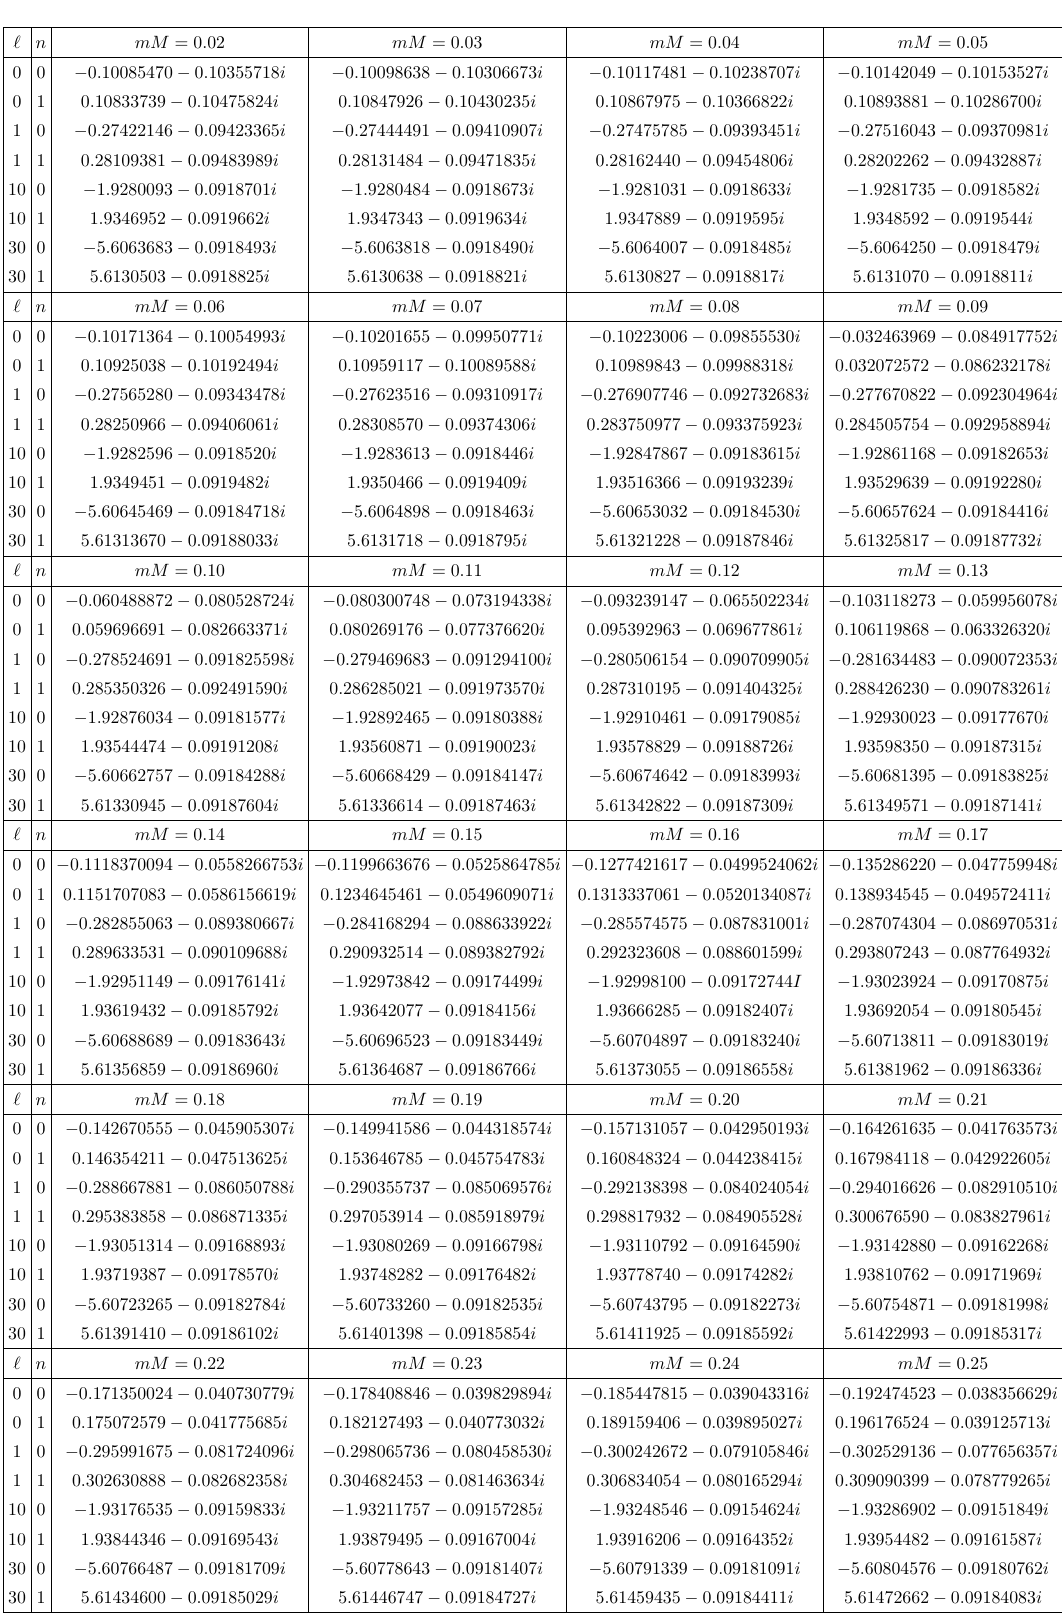
Table 11 . Dominant photon sphere QNFs ( ωM ) for massive scalar fields with qM = 0 . 10 , ‘ = 0 , 1 , 10 , and 30 in the background of a RNdS black hole with Λ M 2 = 0 . 01 , and Q/M = 0 . 1